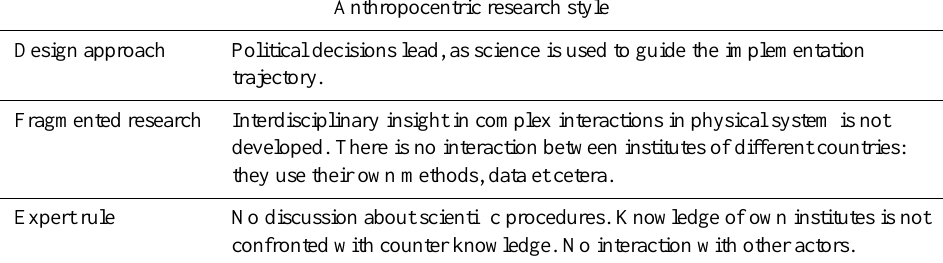
Table 6. Research style